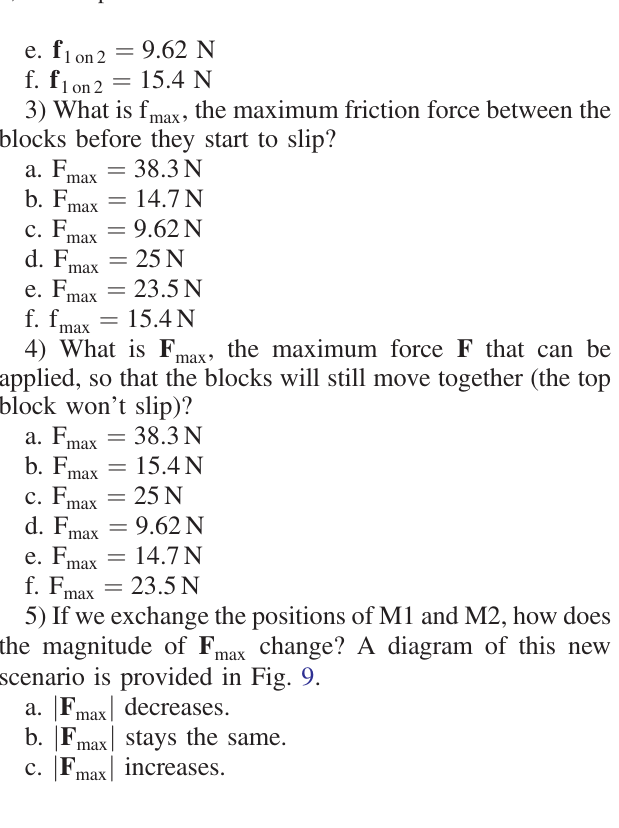
FIG. 9. Diagram provided for question 5 on version A of week 7, level 1 problems.